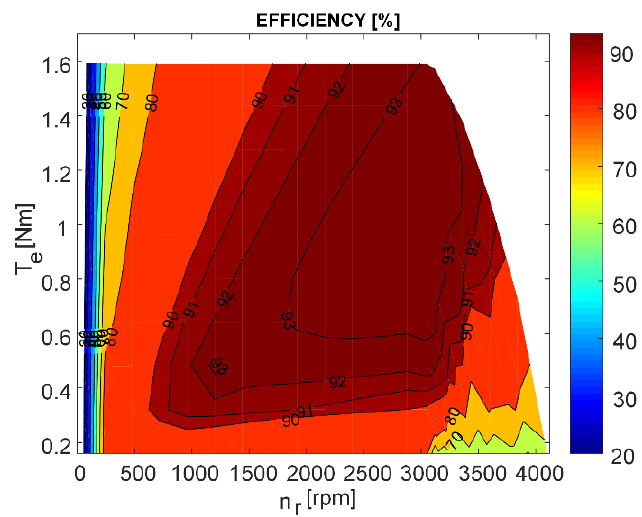
Figure 9. Shimano Steps IPM stator and rotor iron losses.